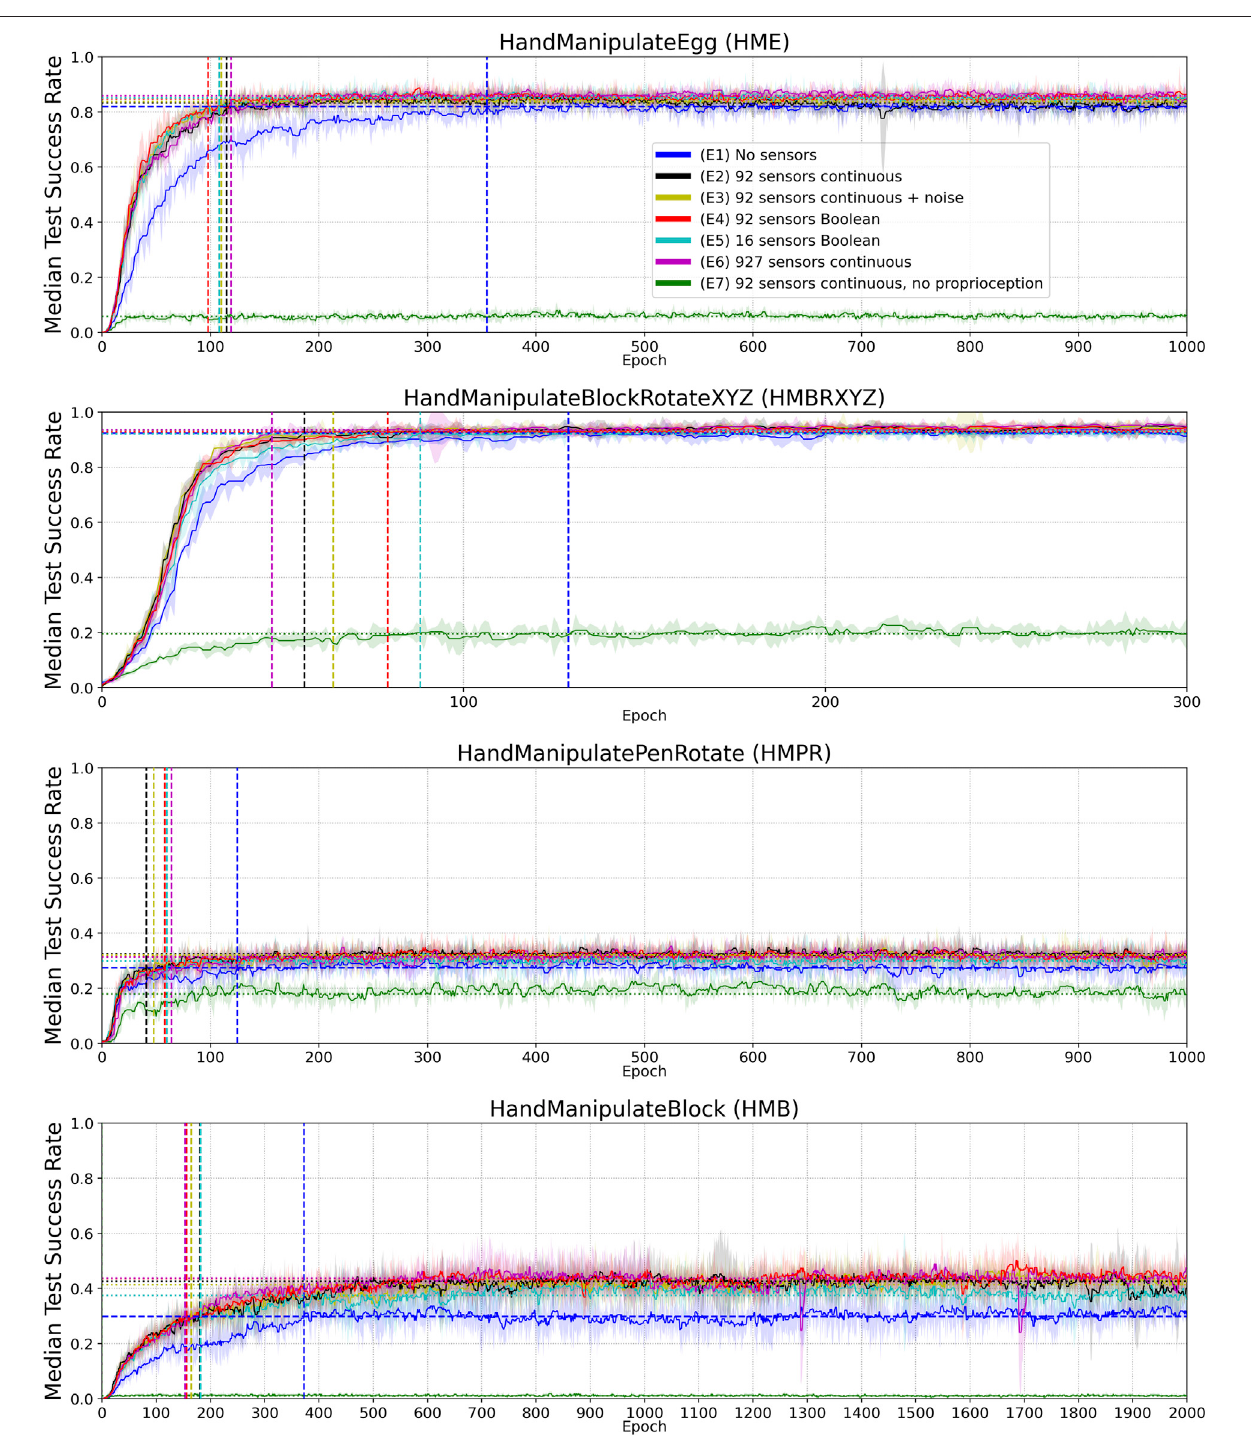
FIGURE A1 | Full version of Figure 4